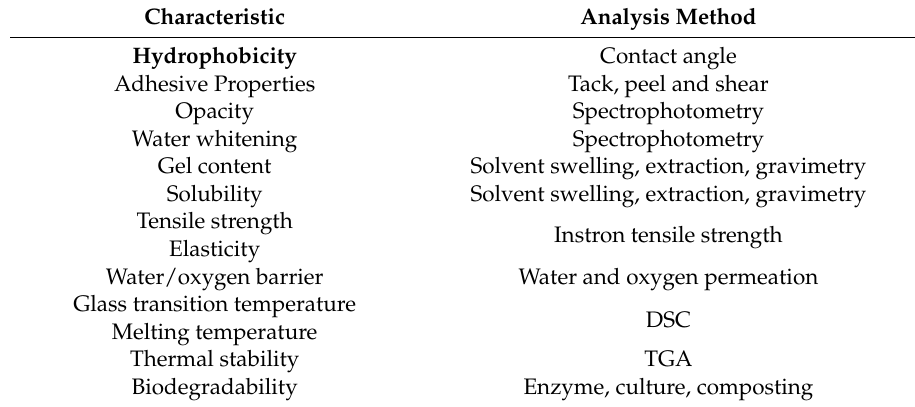
Table 5. Summary of characterization methods for determination of film